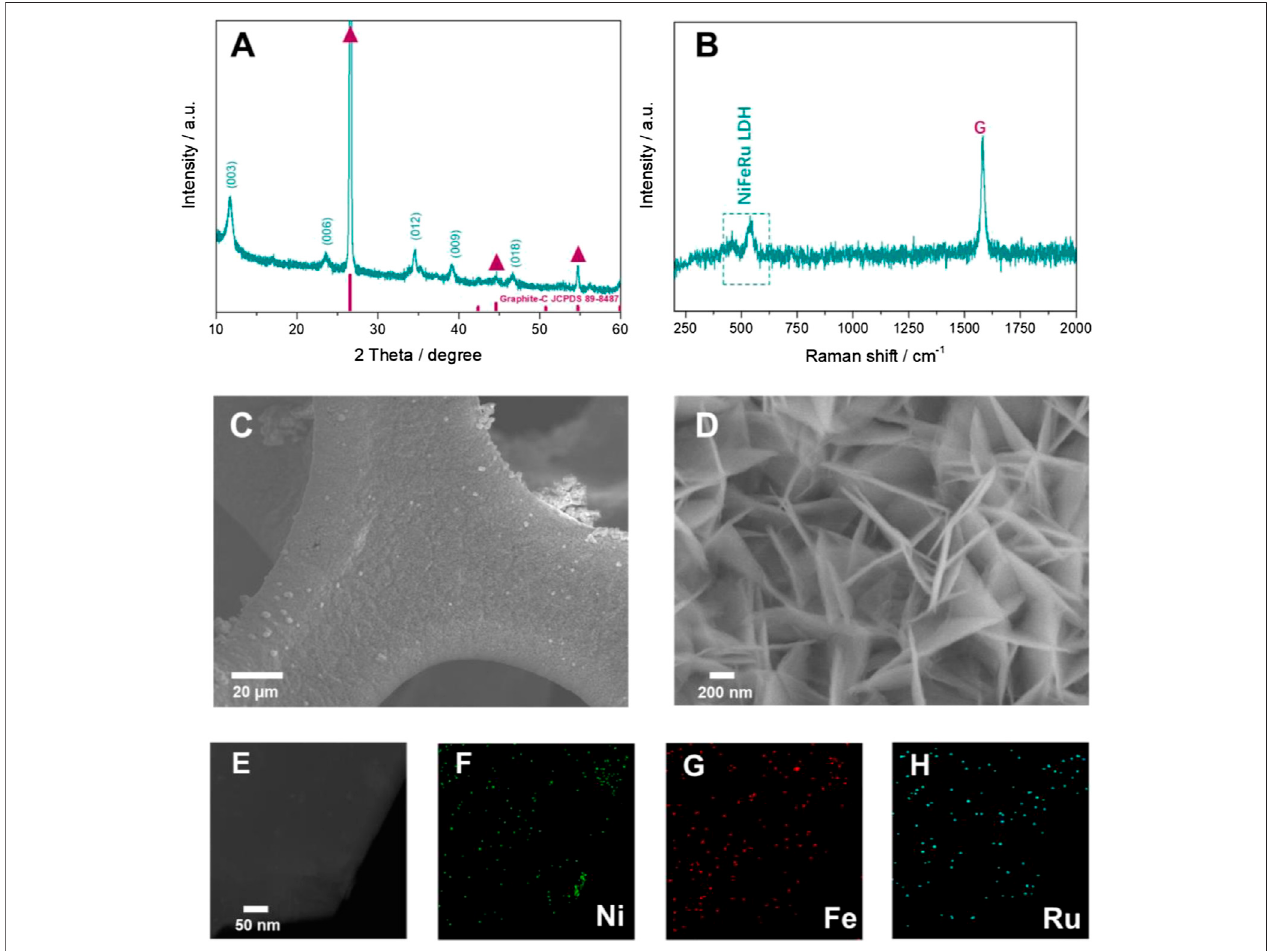
FIGURE 2 | Characterization of the as-fabricated NiFeRu-LDH@GF cathode. Typical (A) XRD, (B) Raman, (C, D) SEM, (E) TEM spectra, and corresponding elemental mapping images of (F) Ni, (G) Fe, and (H) Ru.